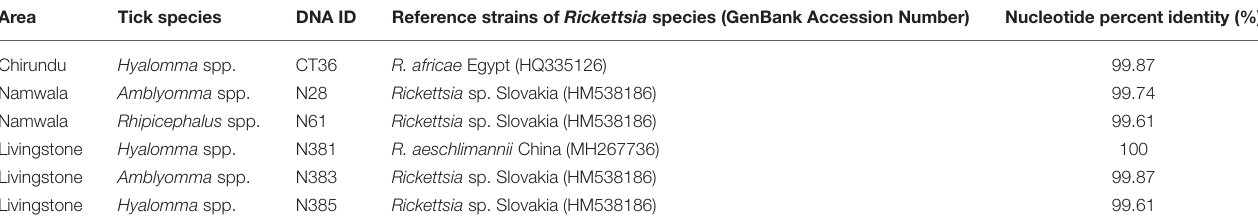
TABLE 2 | Rickettsia identity based on the gltA gene.